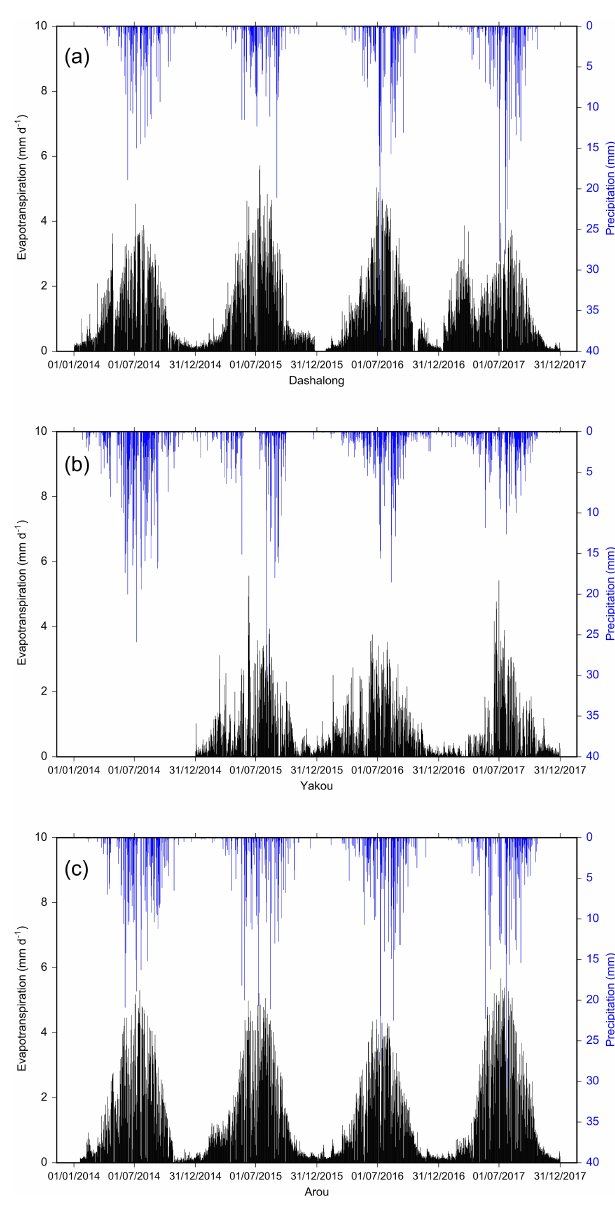
Figure 3. Daily precipitation and ET data at the (a) Dashalong, (b) Yakou and (c) A’rou stations from 2014 to 2017.